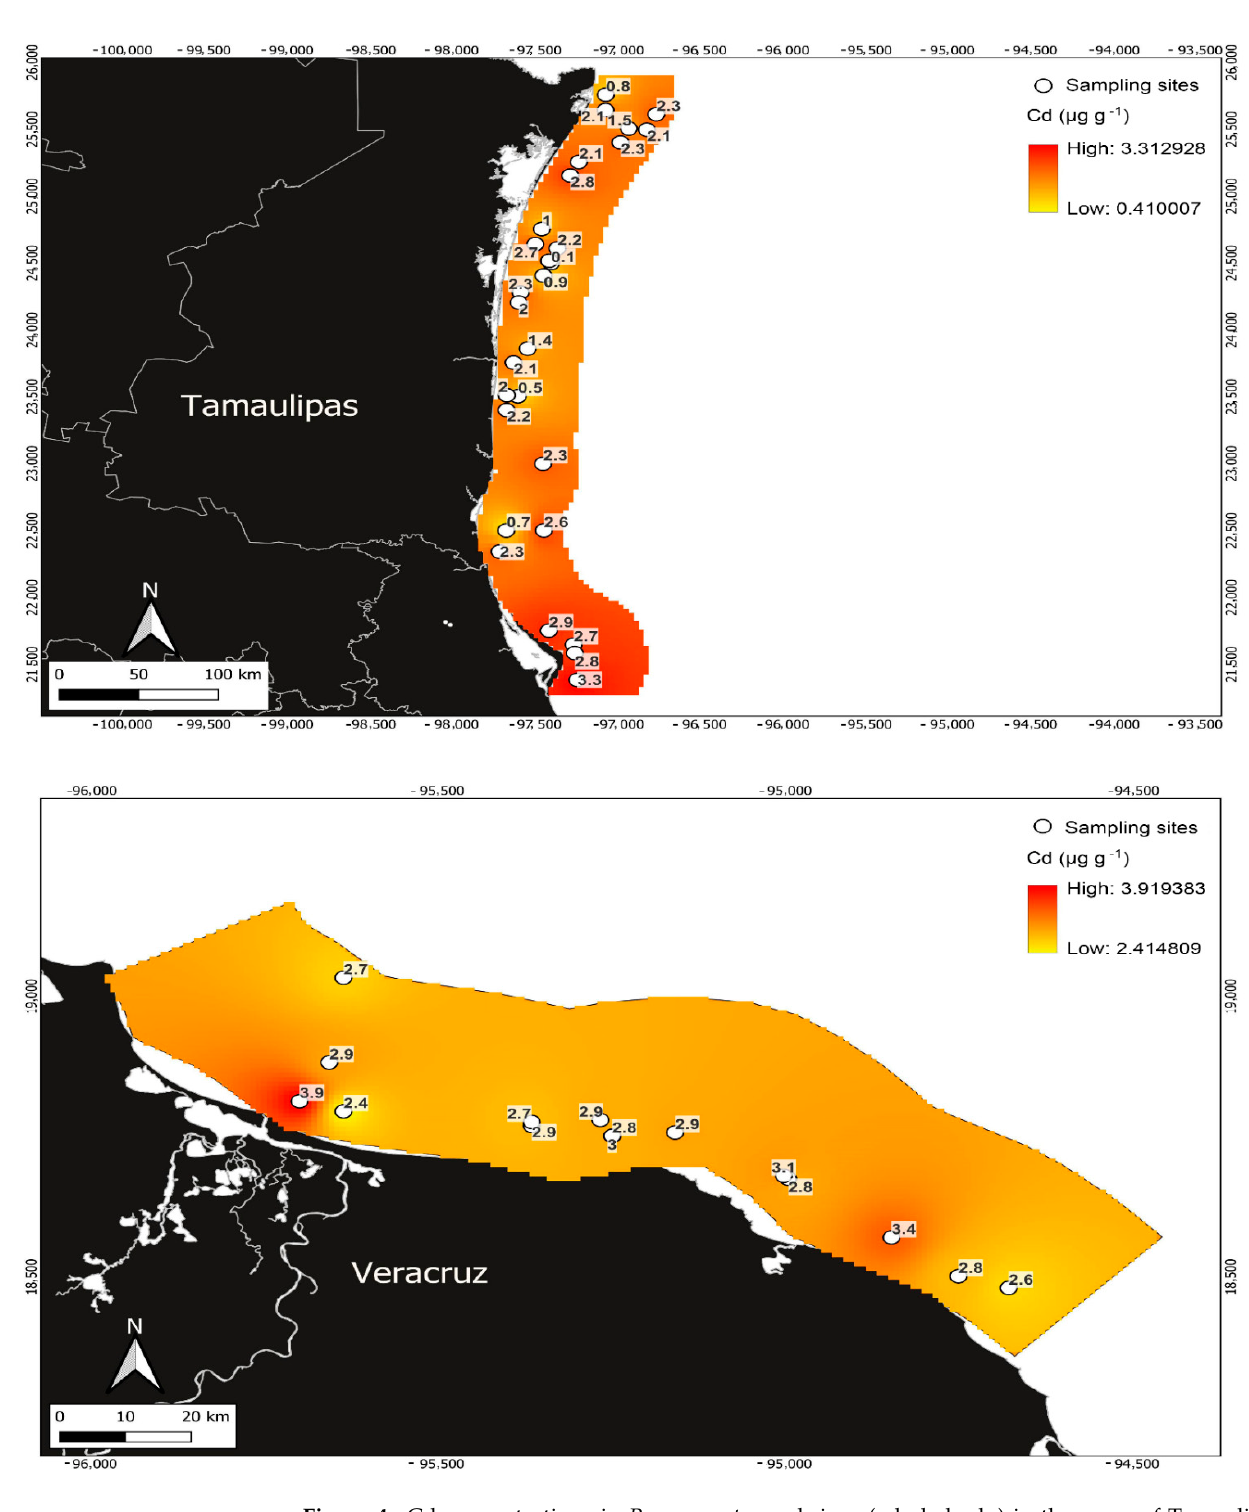
Figure 4. Cd concentrations in Penaeus aztecus shrimp (whole body) in the areas of Tamaulipas ( upper ) and Veracruz ( below ), Mexico.